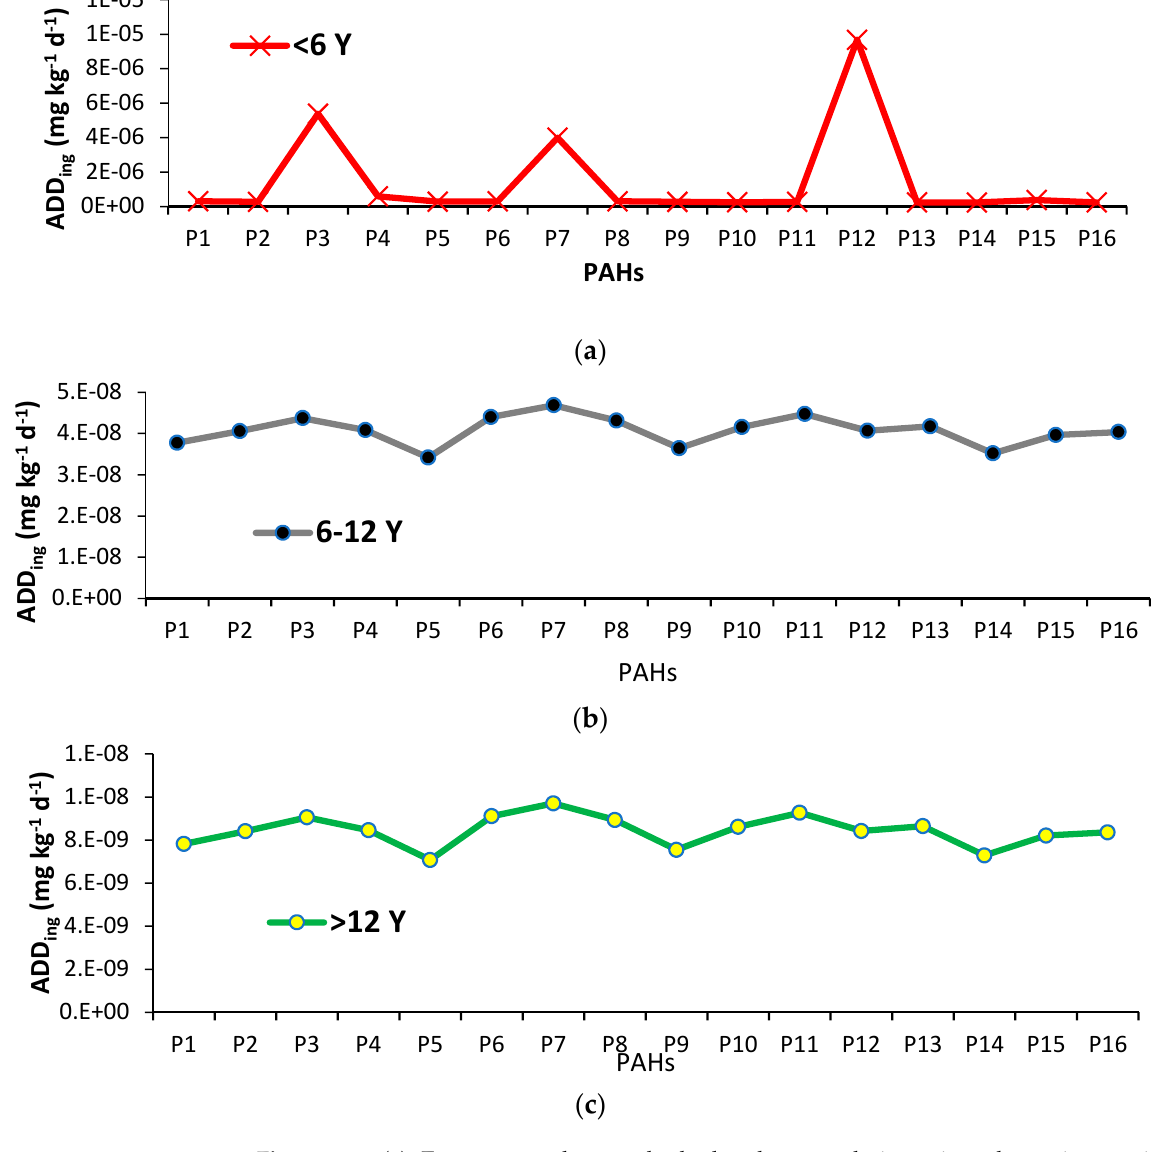
Figure 2. ( a ) Exposure to human body hand ‐ to ‐ mouth ingestion absorption against each PAH for children (<6 years) ( b ) teenagers and ( c ) adults based on mean values P1: naphthalene, P2: acenaphthylene, P3: acenaphthene, P4: fluorene, P5: phenanthrene, P6: anthracene, P7: fluoranthene, P8: pyrene, P9: benzo(b+j)fluoranthene, P10: benzo(k)fluoranthene, P11: benzo(a)pyrene, P12: 3 ‐ methylcholanthrene, P13: dibenz(a.h)acridine, P14: indeno(1.2.3 ‐ cd)pyrene, P15: dibenz(a.h)anthracene, P16: benzo(g.h.i)perylene.